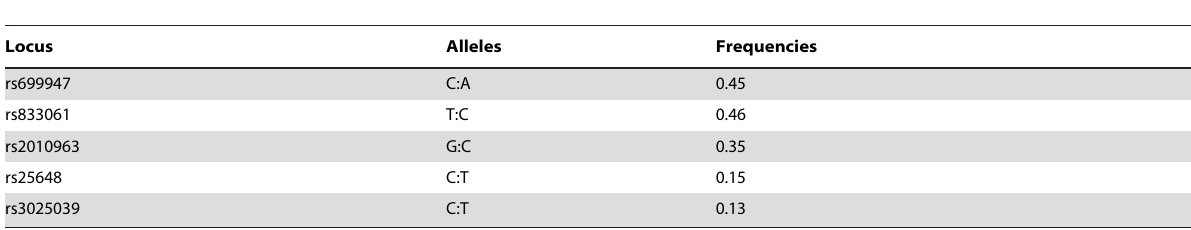
Table 2. Minor allele frequencies (MAF) of the VEGF polymorphisms studied in CLL patients.